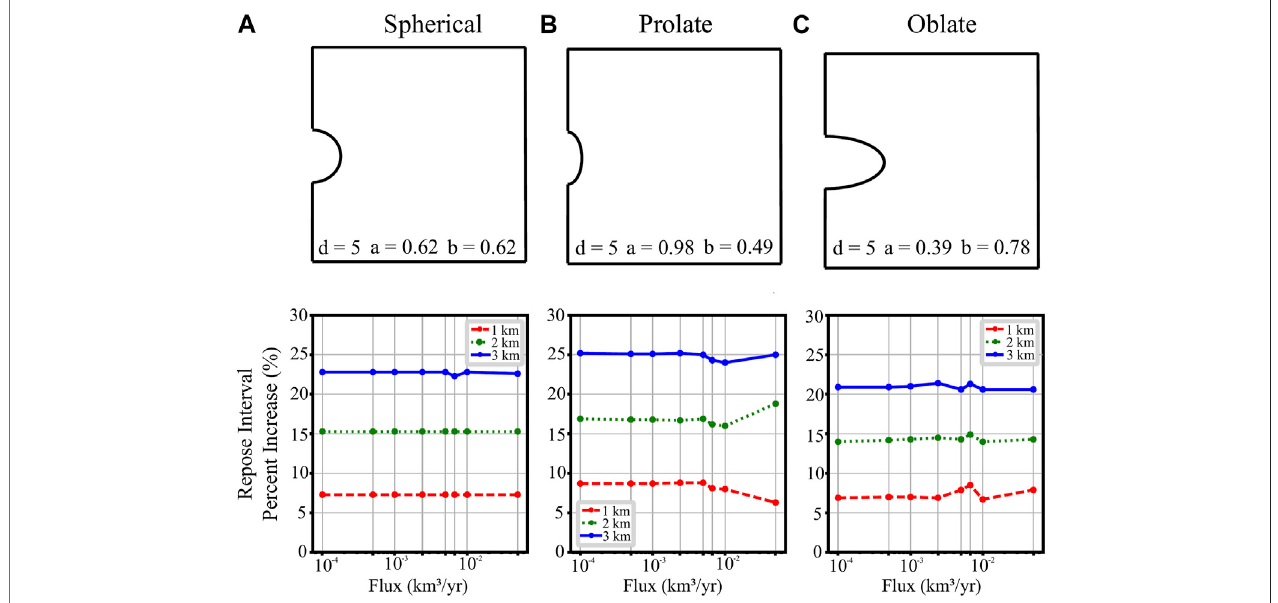
FIGURE 3 | Flux rate versus percent change in the repose intervals of volcanic systems with spherical, prolate, and oblate magma chamber geometries. (A) In the sphericalcase,amagmachamberwithradius~0.62and5 kmdepthtocenterismodeled.Fluxratesrangefrom0.0001-0.05 km 3 /yrandpercentchangesduetoanice cap thickness of 1, 2, and 3 km are represented by the dashed red line, dotted green line, and solid blue line respectively. (B) A prolate chamber with depth of 5 km, horizontal radius of ~0.49 km, and vertical radius of ~0.98 km is modeled. (C) An oblate chamber with ~0.78 km horizontal radius, ~0.39 km vertical radius, and depth of 5 km is